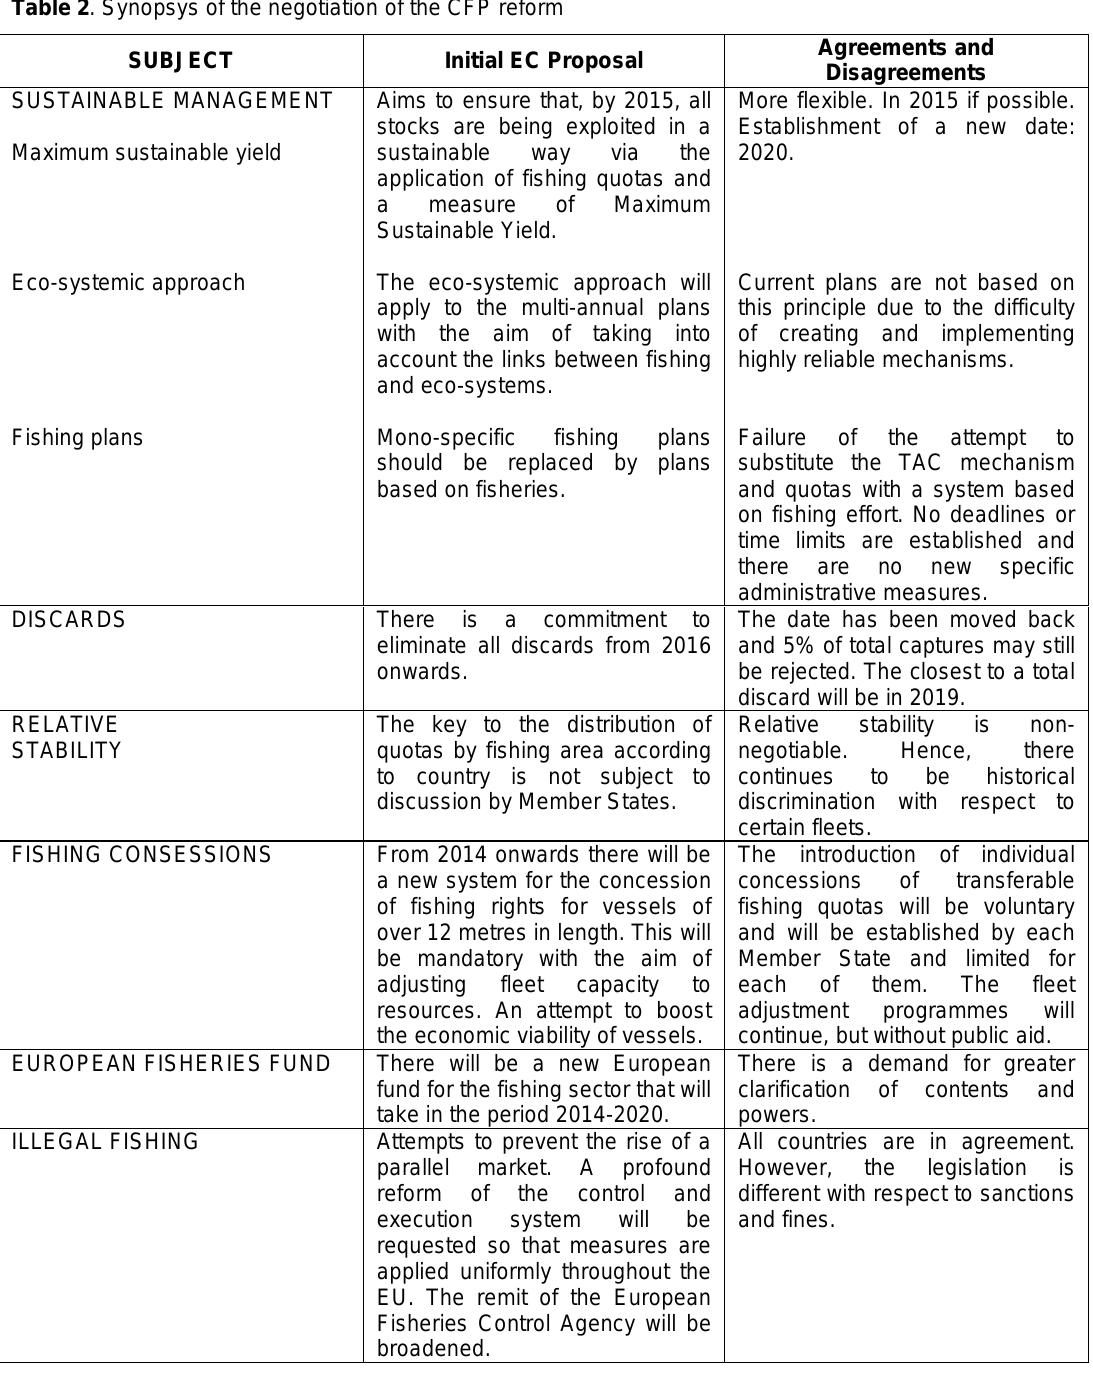
Table 2 . Synopsys of the negotiation of the CFP